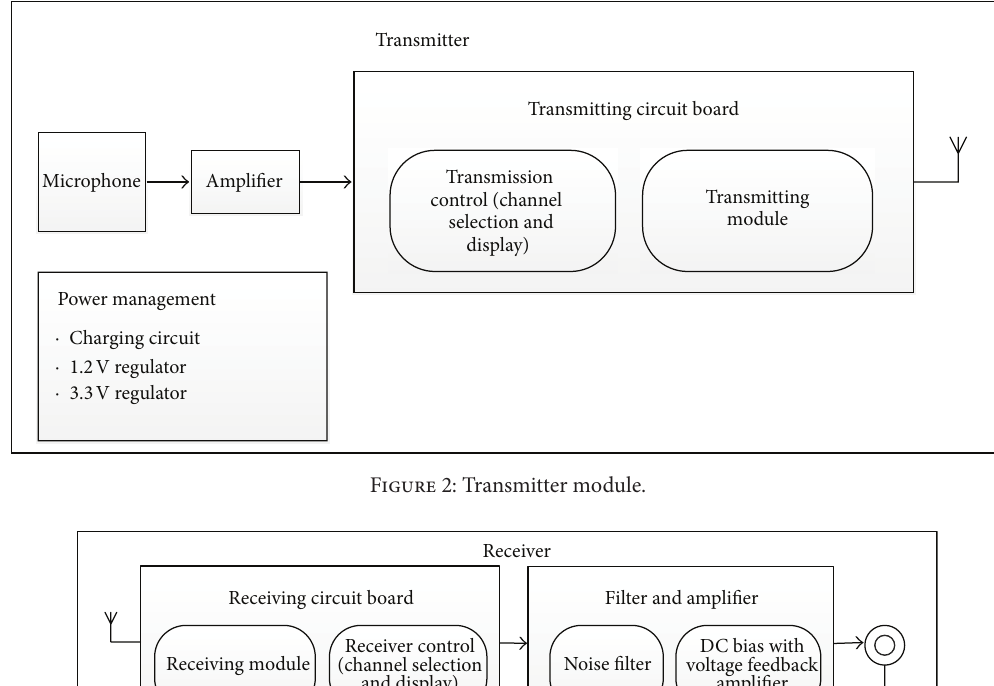
Figure 3: Receiver